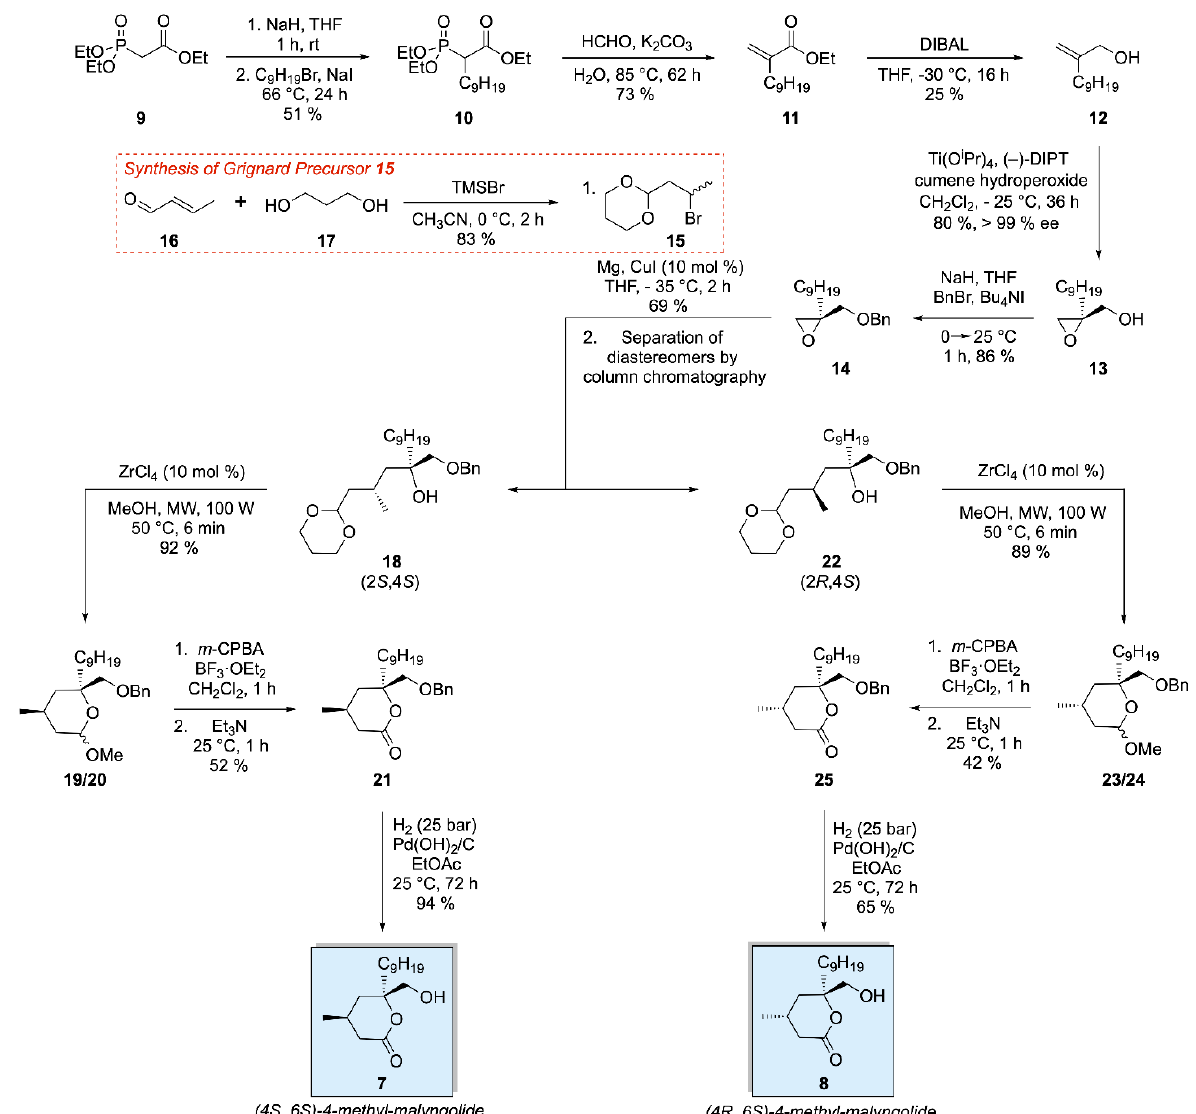
Figure 3. Synthesis of malyngolide analogues 7 and 8 .